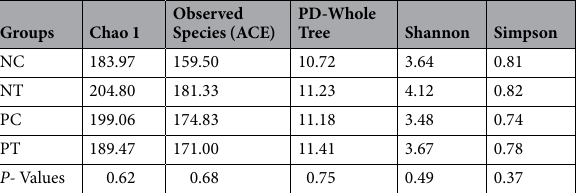
Table 1. Effect of dietary E . faecium on pyrosequencing data and microbiota α -diversity indices in cecal feces of broiler chickens challenged with NE (d 26, 7 DPI). NC, neither NE infection nor E . faecium in the feed; NT, no NE infection but with E . faecium in the feed; PC, with NE infection but without E . faecium in the feed; PT, NE infection and E . faecium in the